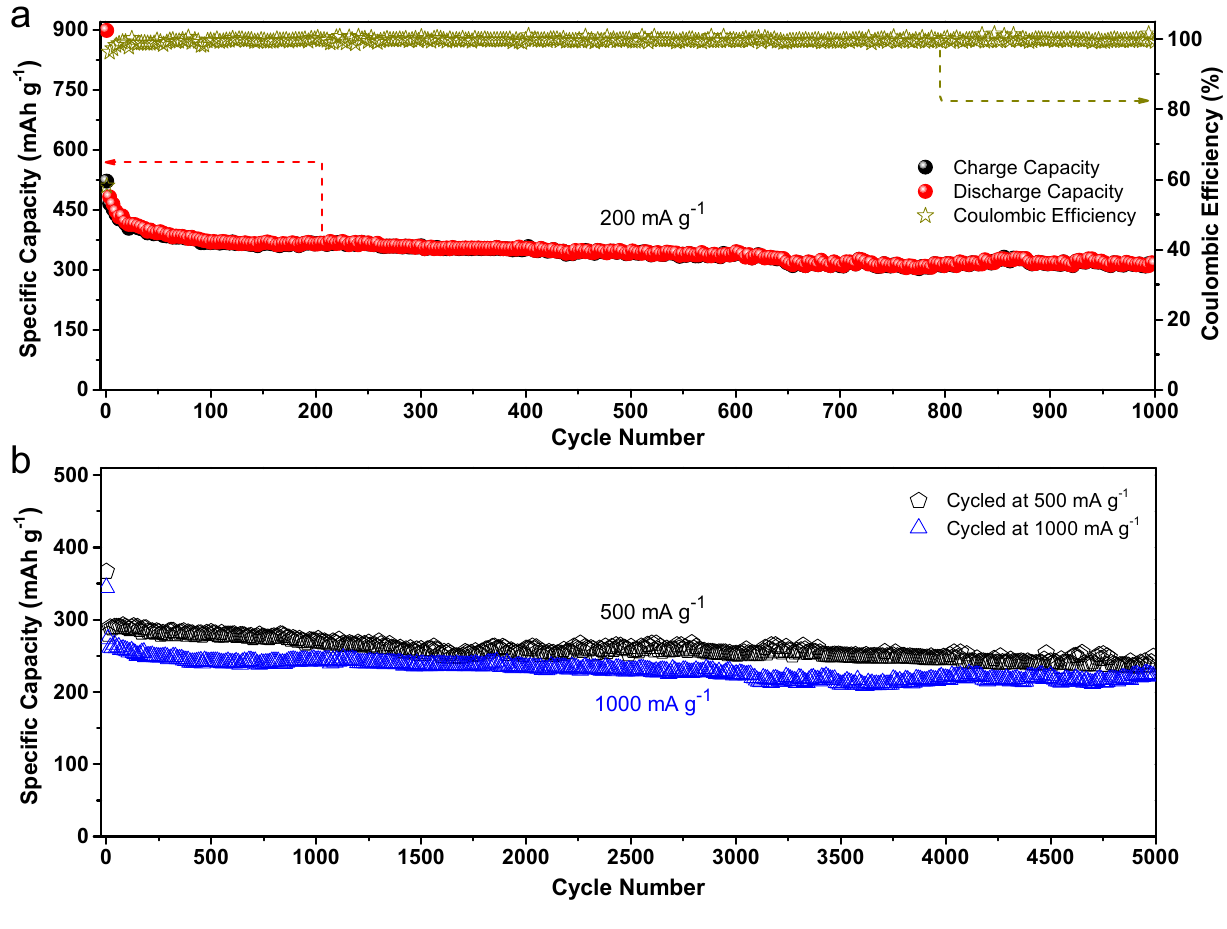
Figure 7. Long cycling performance of Alg-C electrodes. ( a ) At a current density of 200 mA g − 1 for 1000 cycles and the corresponding Coulombic efficiency. ( b ) At high current densities of 500 and 1000 mA g − 1 for 5000 cycles after aging for three cycles at 100 mA g − 1 .